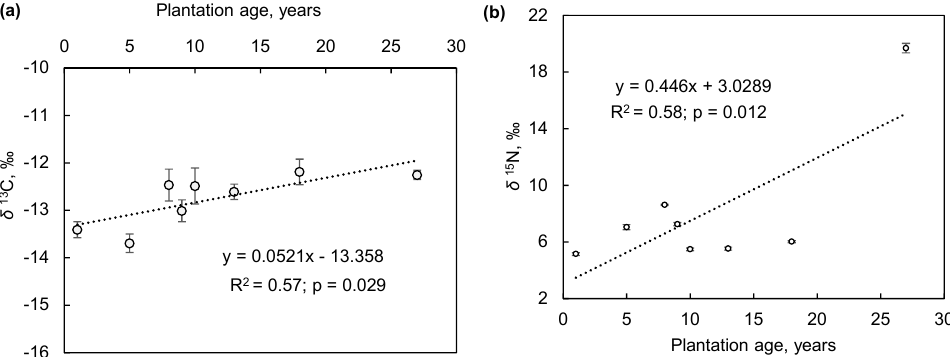
Figure 3. Temporal trends of δ 13 C ( a ) and δ 15 N ( b ) in photosynthetic organs of Haloxylon aphyllum plants in afforestation chronosequence sites (1991–2017; plantations aged 1–27 years) in northern Aralkum.